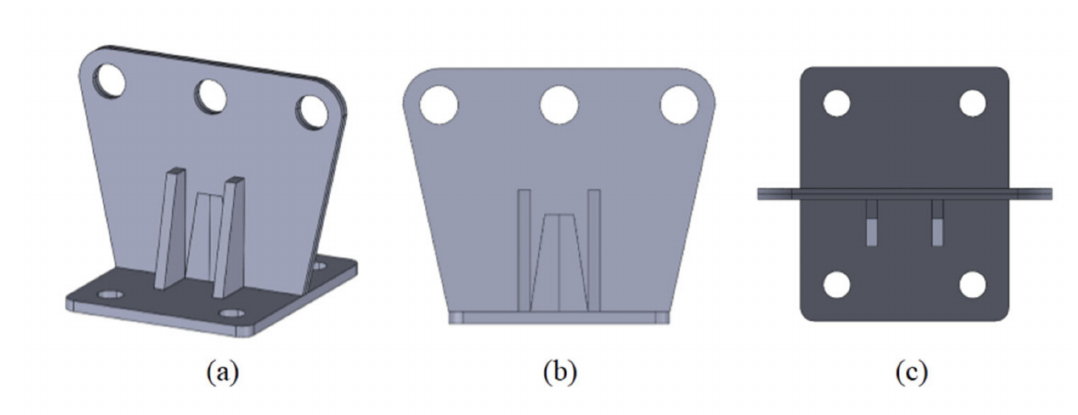
Figure 1. Original structure of the aerospace bracket. ( a ) represents the angle-specific view of original structure; ( b ) represents front view of original structure; ( c ) represents top view of original